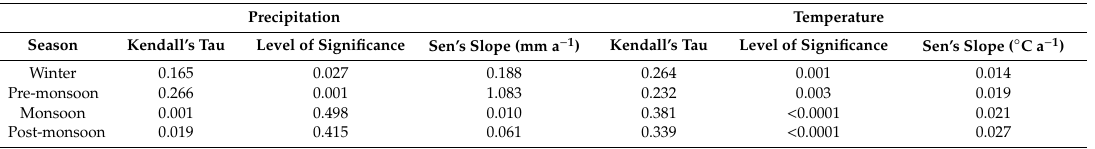
Table 1. Long-term (1950–2016) trend analysis of monthly precipitation and temperature in the